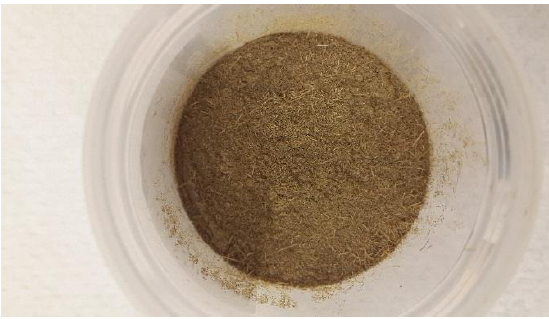
Figure 2. Stevia leaves powder.